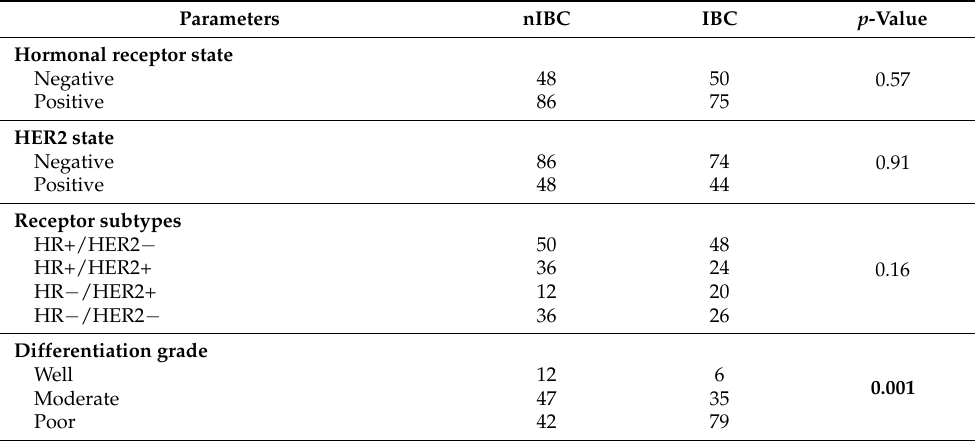
Table 2. Categorical clinicopathological parameters. Comparison between nIBC and IBC was done using a Chi-square test. nIBC: non-inflammatory breast cancer, IBC: inflammatory breast cancer, RD: residual disease, pCR: complete pathological response, sTIL: stromal tumour infiltrating lymphocytes and NACT: neo-adjuvant chemotherapy. * median value used for dichotomization. Bold values denote statistical significance at the p < 0.05